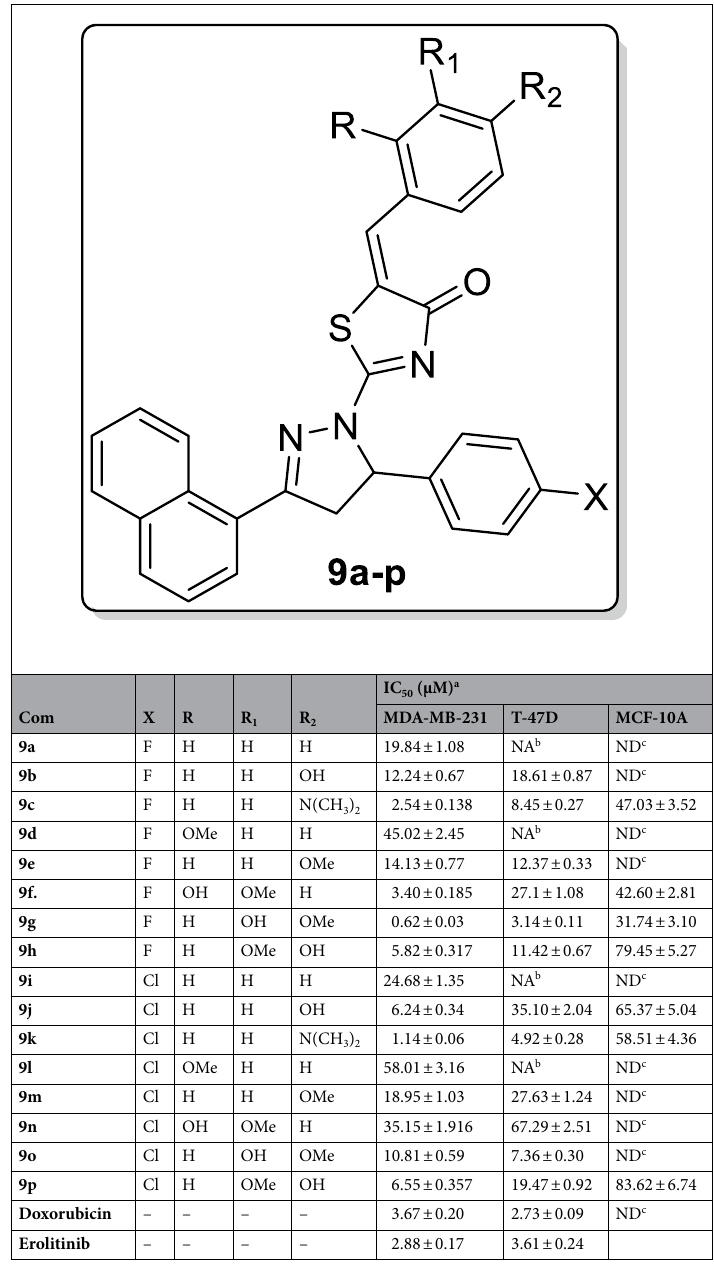
Table 1. Anti-proliferative activity of pyrazolines 9 BC MDA-MB-231 and T-47D cancer cell lines, as well as towards breast MCF-10A normal cells. a IC 50 value is the mean ± S.D. of 3 separate experiments. b NA: Derivatives with IC 50 more than 100 mM. c ND: Not